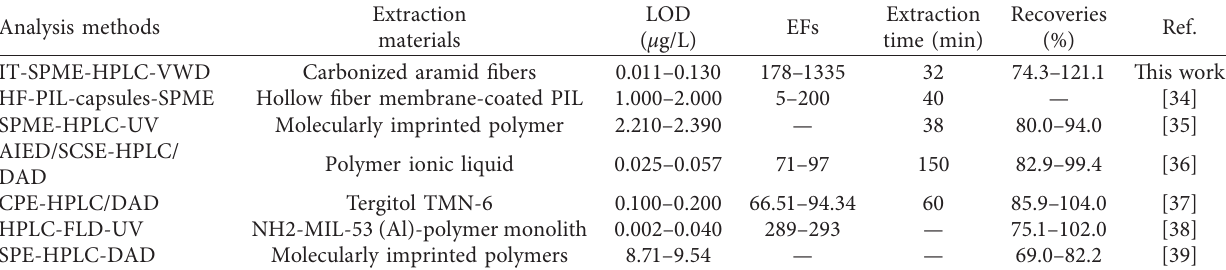
Table 3: Comparison with other reported methods for the determination of estrogens.